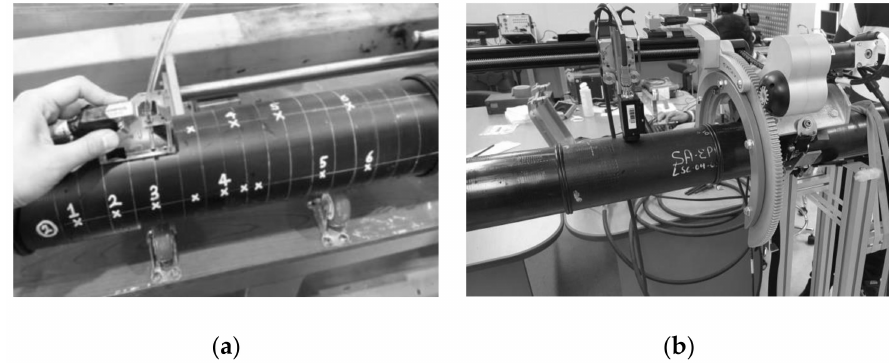
Figure 2. ( a ) PAUT and ( b ) MWI for non-destructive inspection of windows in